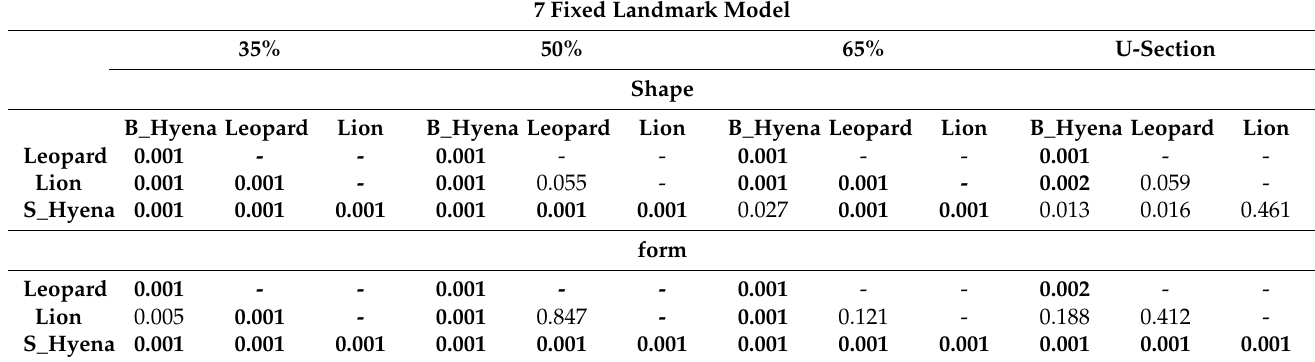
Table 2. MANOVA p -values obtained on the 7-landmark models used to describe the score cross- sections at different lengths. Statistical significance ( p < 0.003) is marked in